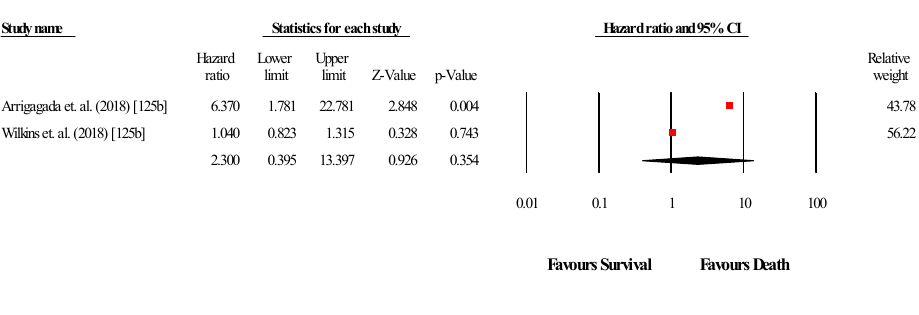
Figure 9. Forest plot for miR-125b for association with OS.